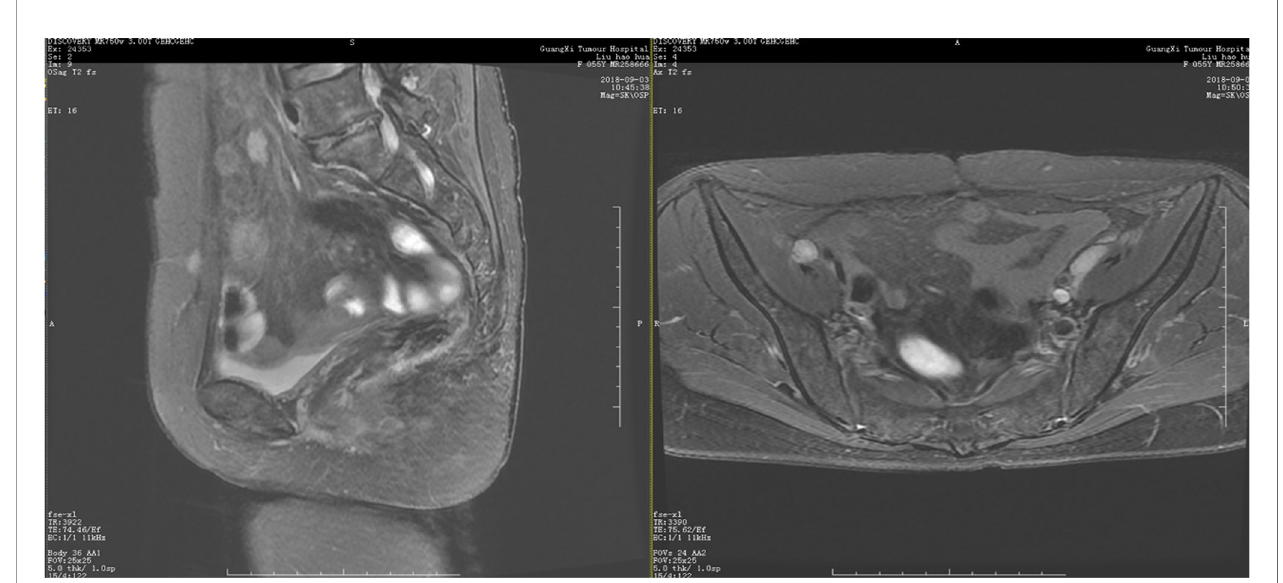
FIGURE 3 | Pelvic MRI on September 3, 2018. Coronal view showing no new lesions after niraparib administration for one year.